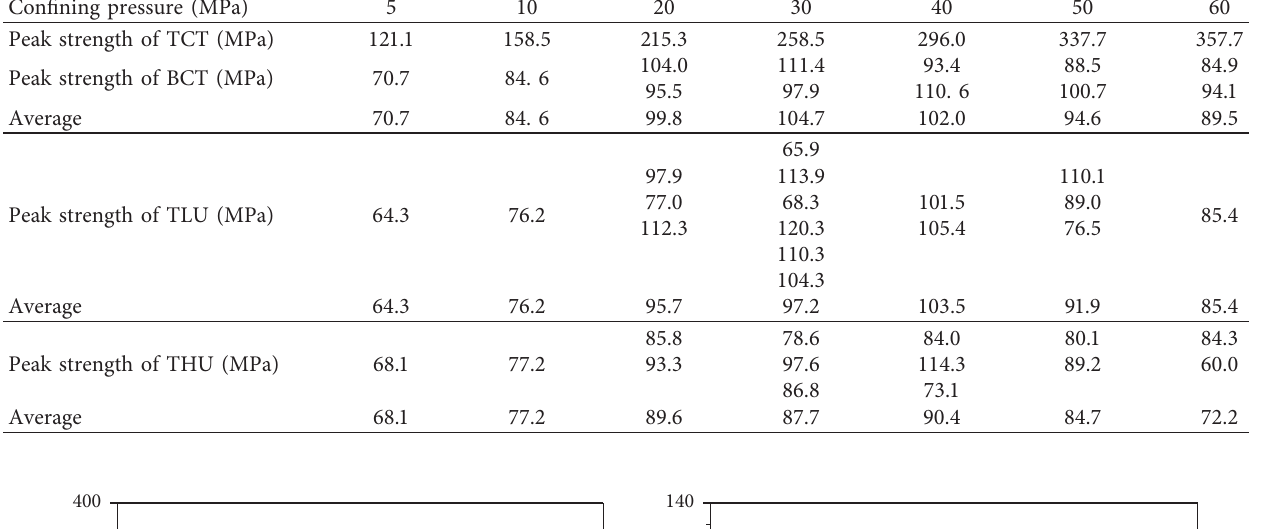
Table 1: Peak strength of each test at different confining pressures.